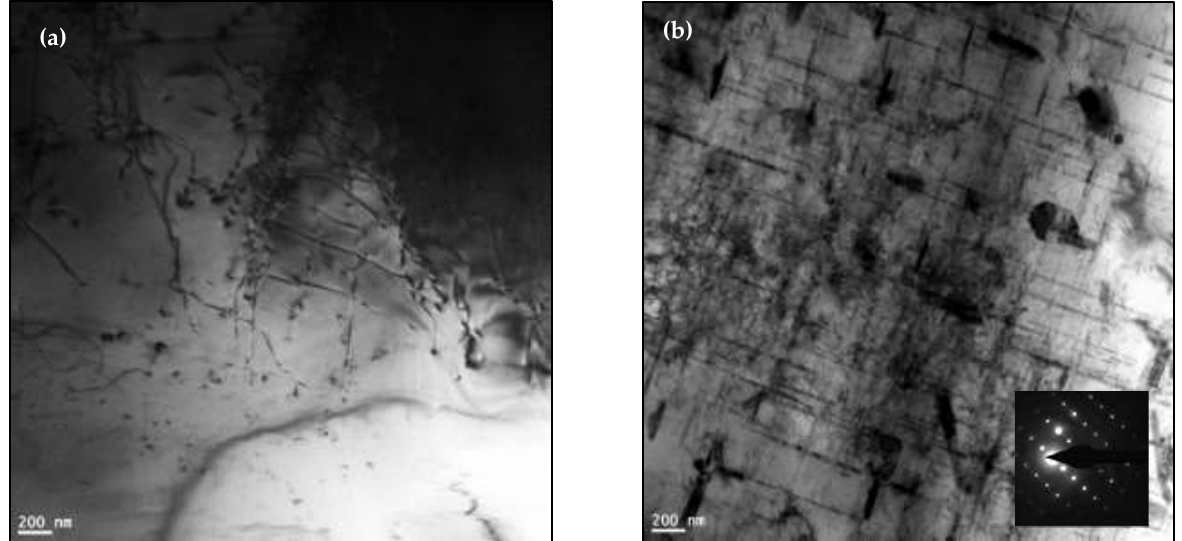
Figure 6. Schematic representation showing the influence of increasing the aging temperature on the size, density, and inter-particle spacing of the hardening precipitates: ( a ) at a low aging temper- ature and ( b ) at a high aging temperature. (L1 and L2 indicate the inter-particle spacing in each case.). The black arrows represent the dislocations motion through the precipitates.